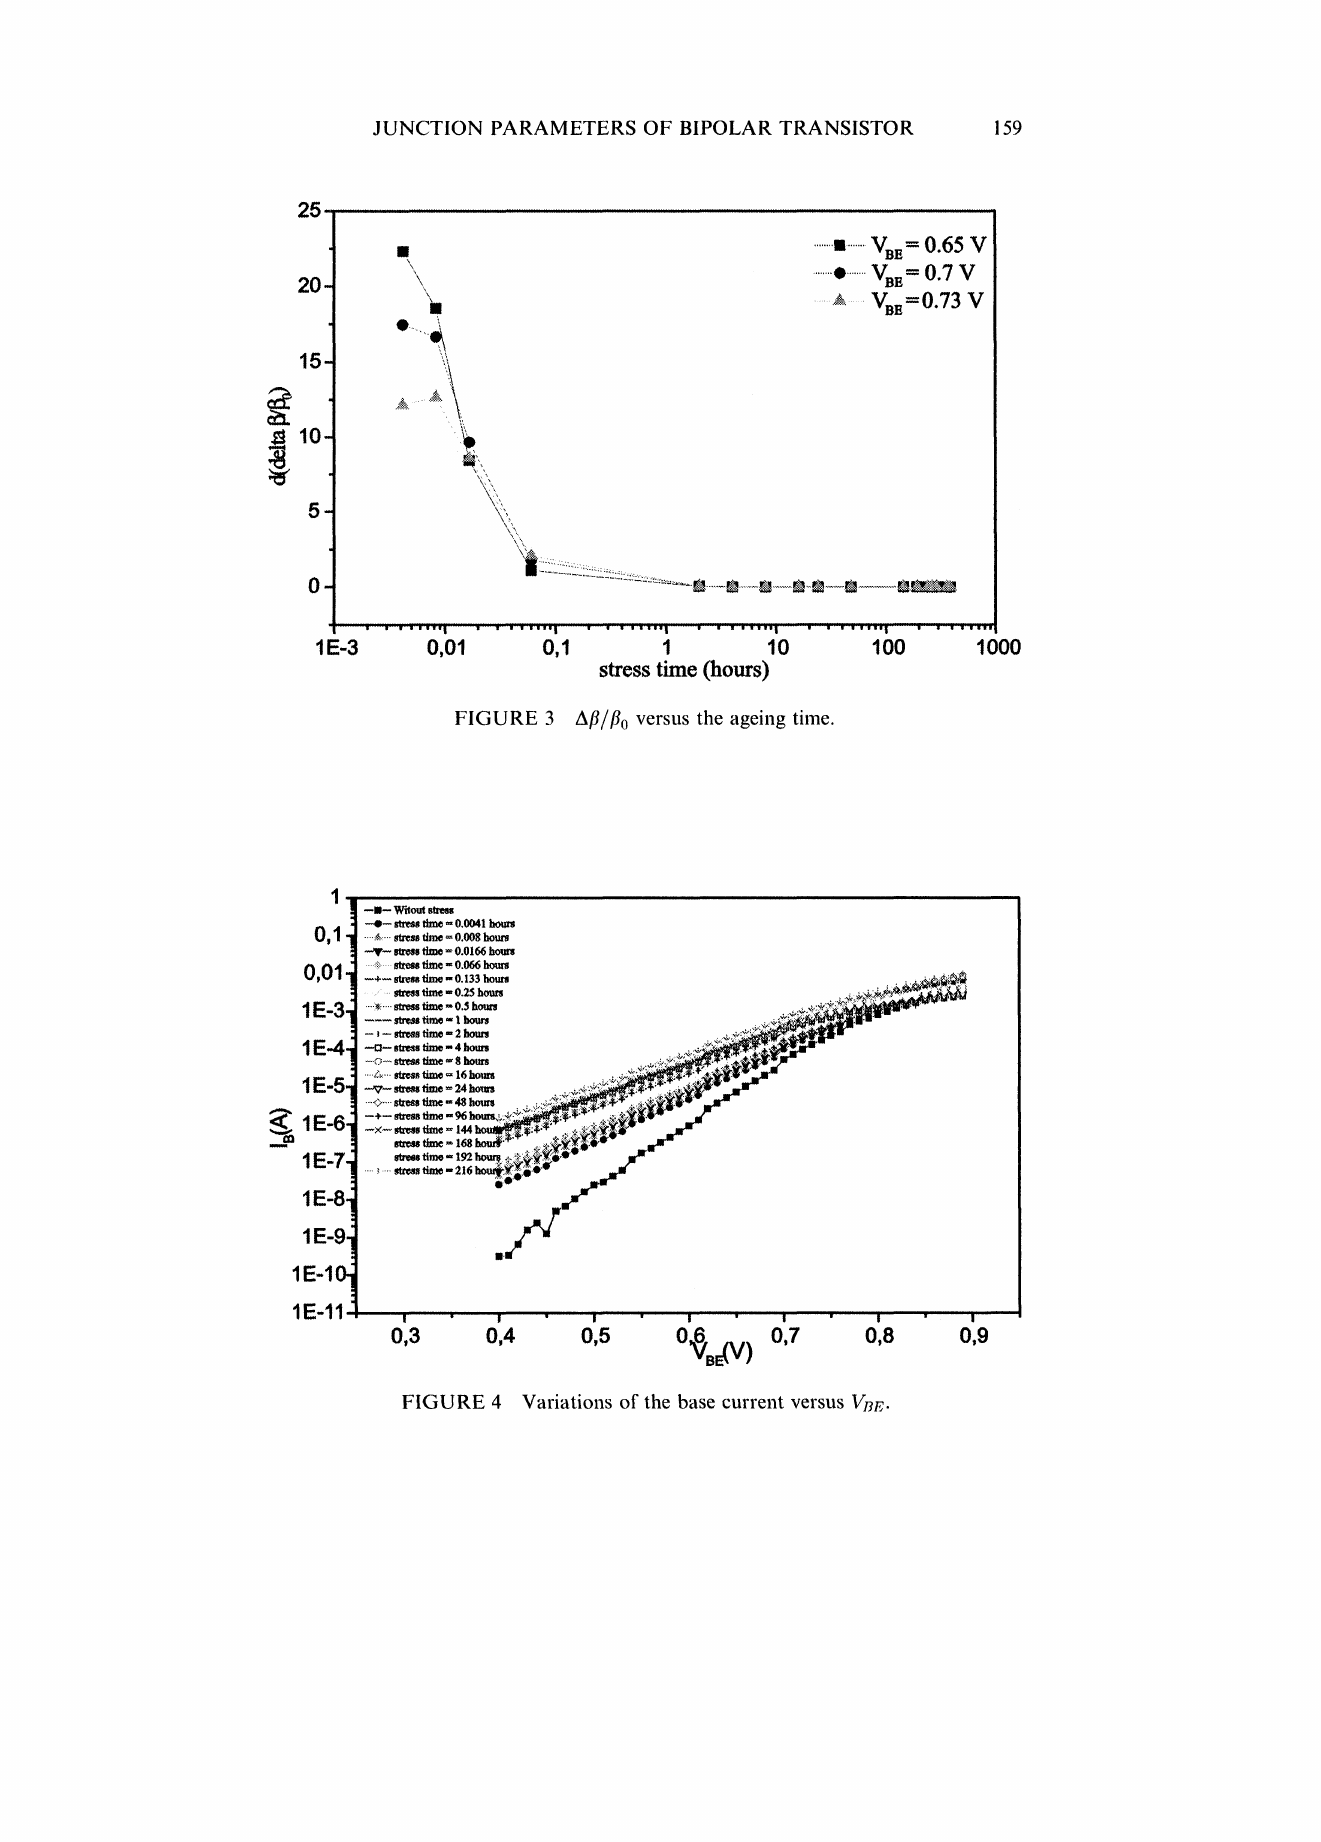
FIGURE 4 Variations of the base current versus